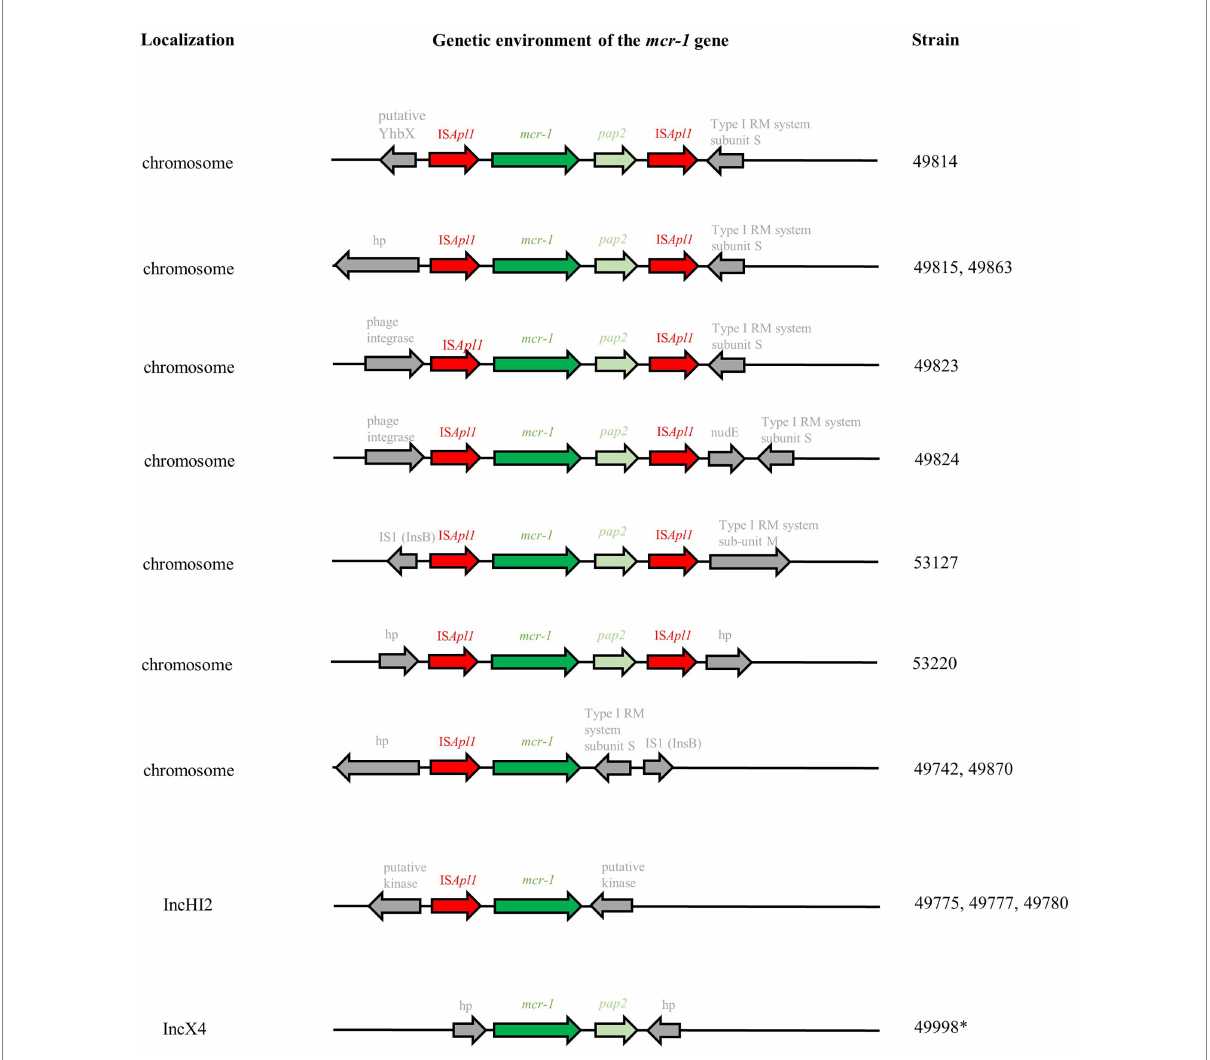
FIGURE 3 Genetic environment of mcr-1 genes based on Illumina-ONT hybrid assemblies. RM: restriction-modification; hp: hypothetical protein. *Analyses based on Illumina sequences